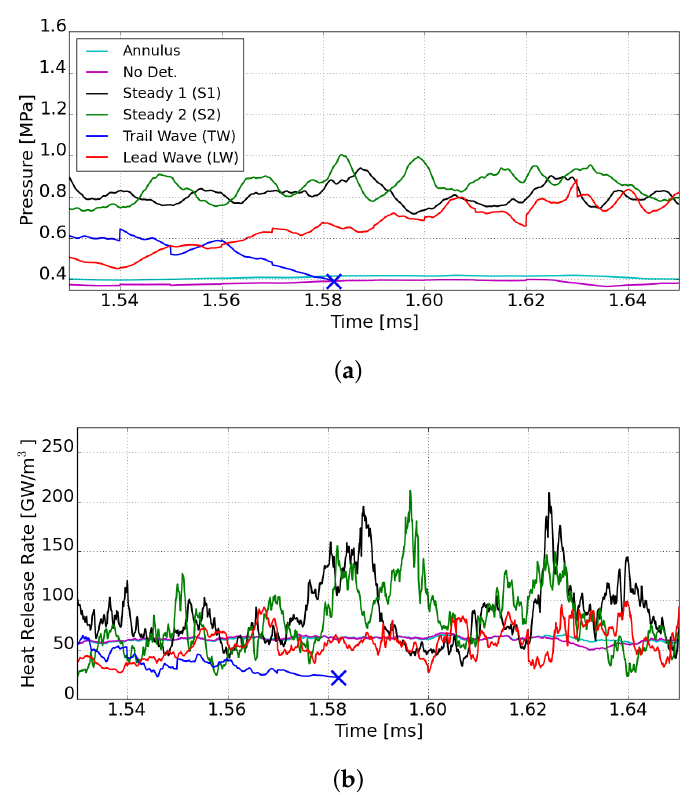
Figure 15. Local integrated ( a ) pressure and ( b ) heat release divided by region volume for each respective detonation wave, non-detonation regions, and entire